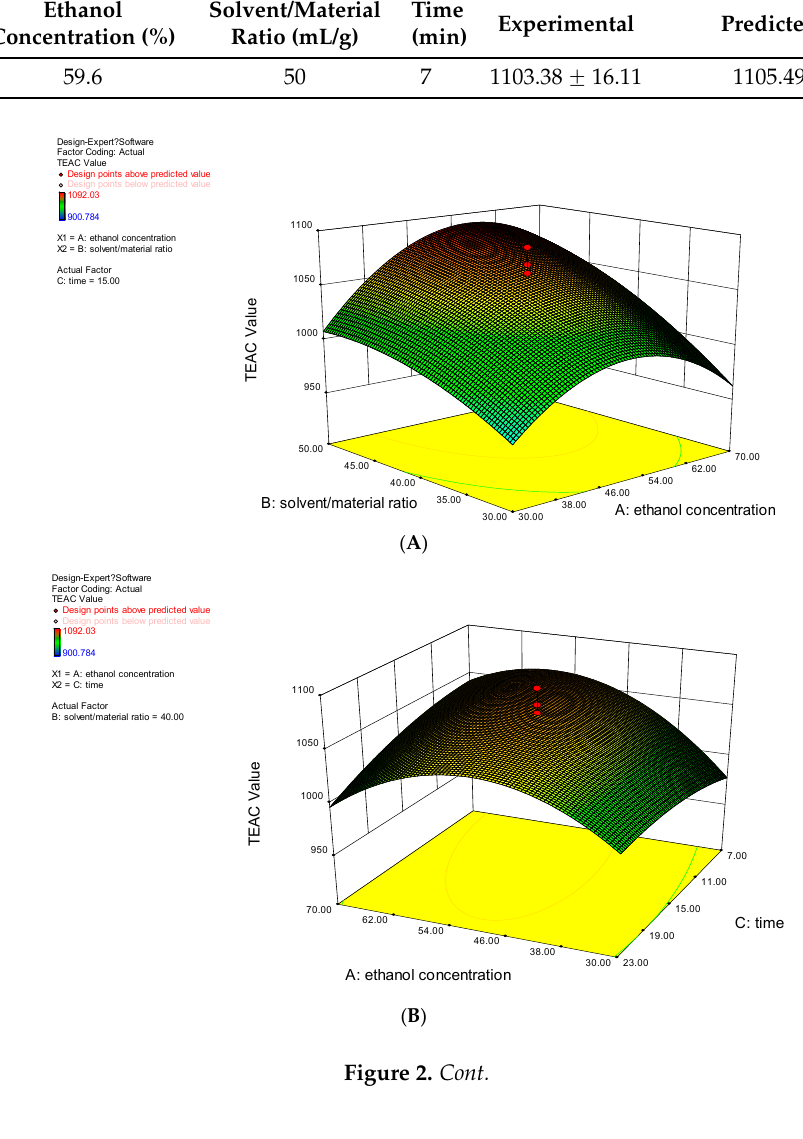
Table 3. Optimum conditions, predicted and experimental value.